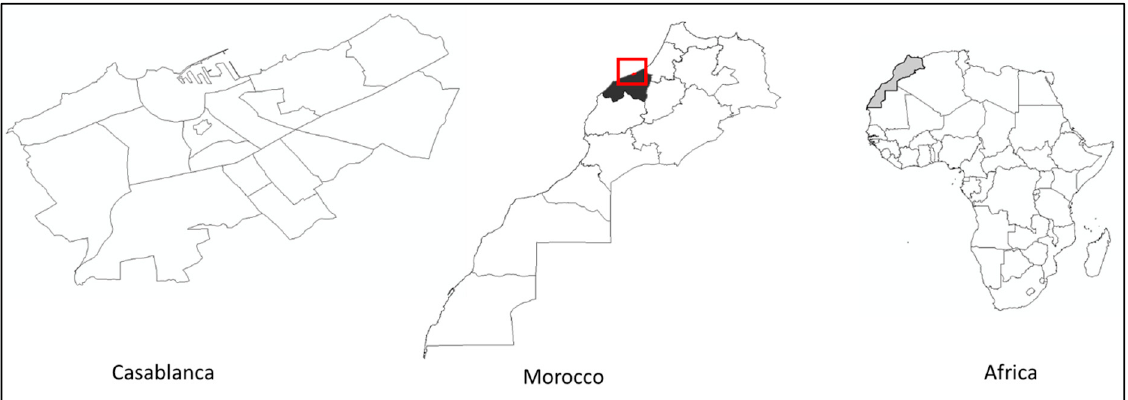
Figure 2. Casablanca’s location.